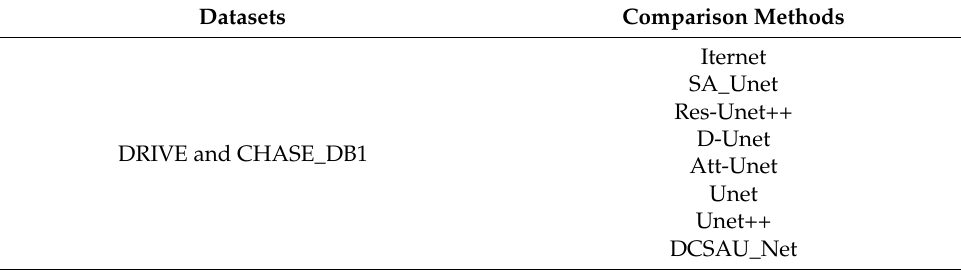
Table 3. Methods compared by the